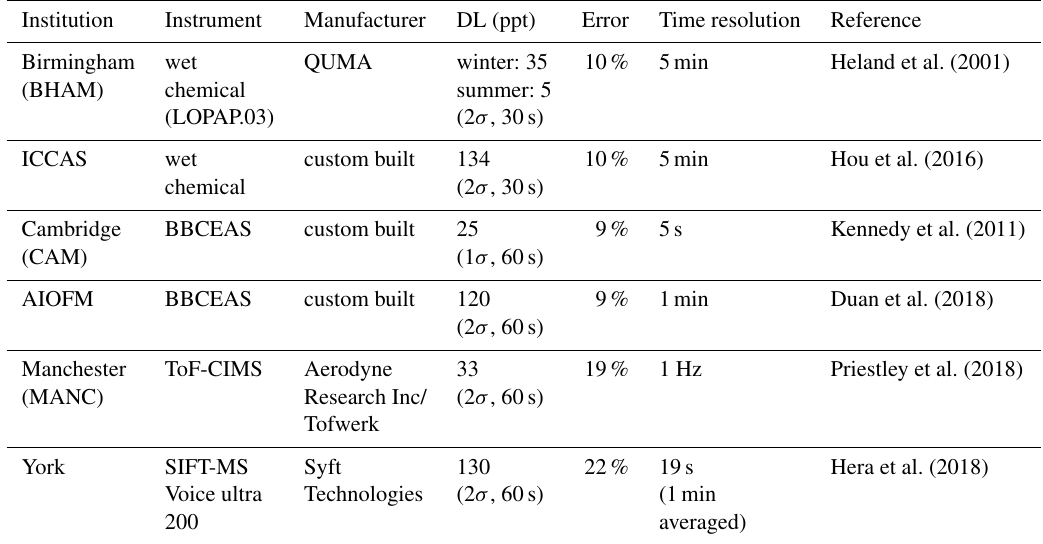
Table 1. Instrumentation measuring HONO at